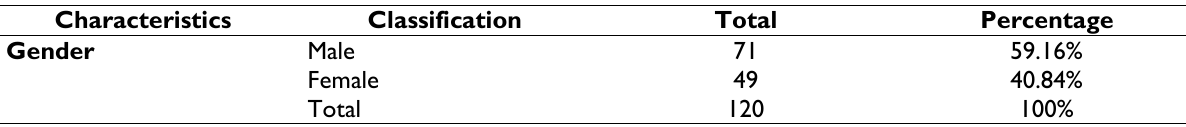
Table 1. The Respondents'